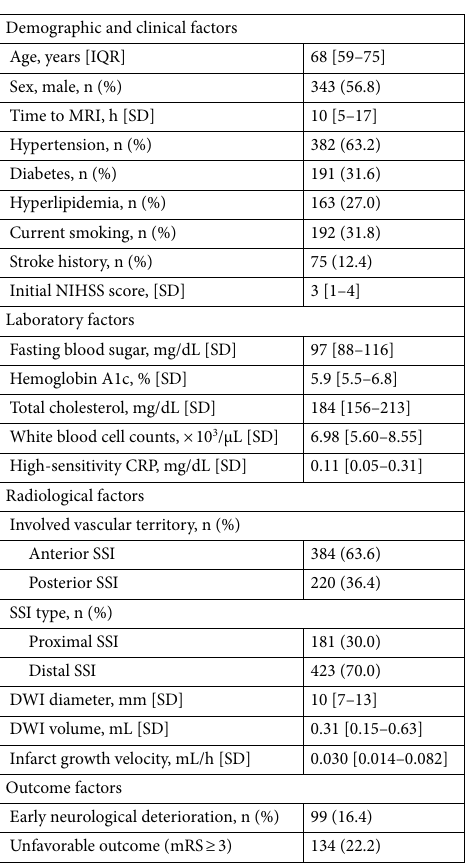
Table 1. Baseline characteristics of the study population (n = 604). MRI magnetic resonance imaging, NIHSS National Institutes of Health Stroke Scale, CRP C-reactive protein, SSI single subcortical infarction, DWI diffusion-weighted imaging, mRS modified Rankin